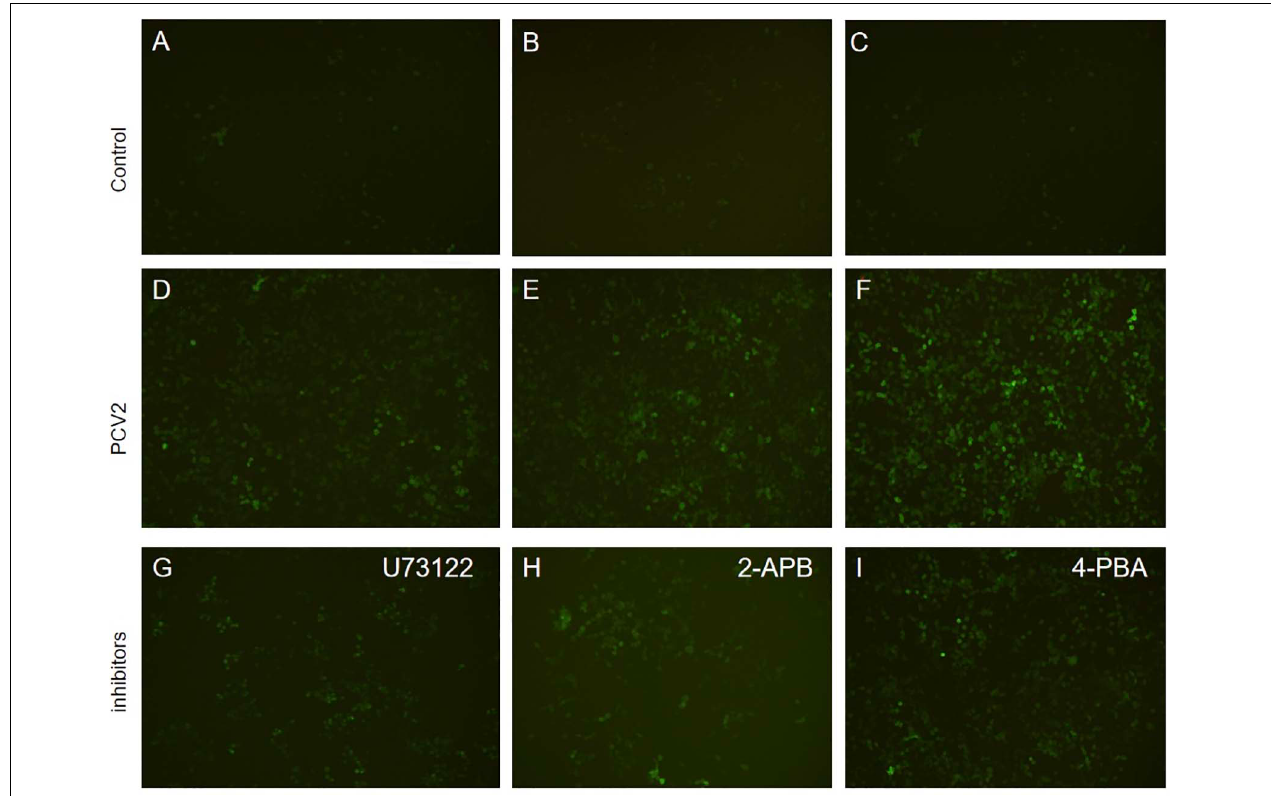
FIGURE 6 | Fluorescence results of apoptosis detection ( × 200). (A–C) Apoptosis in the control group. (D–F) Apoptosis of cells infected with PCV2 virus after 72 h. (G) Apoptosis after adding PLC inhibitor (U73122). (H) Apoptosis after adding IP3R receptor inhibitor 2-APB. (I) Apoptosis after adding endoplasmic reticulum stress inhibitor 4-PBA.